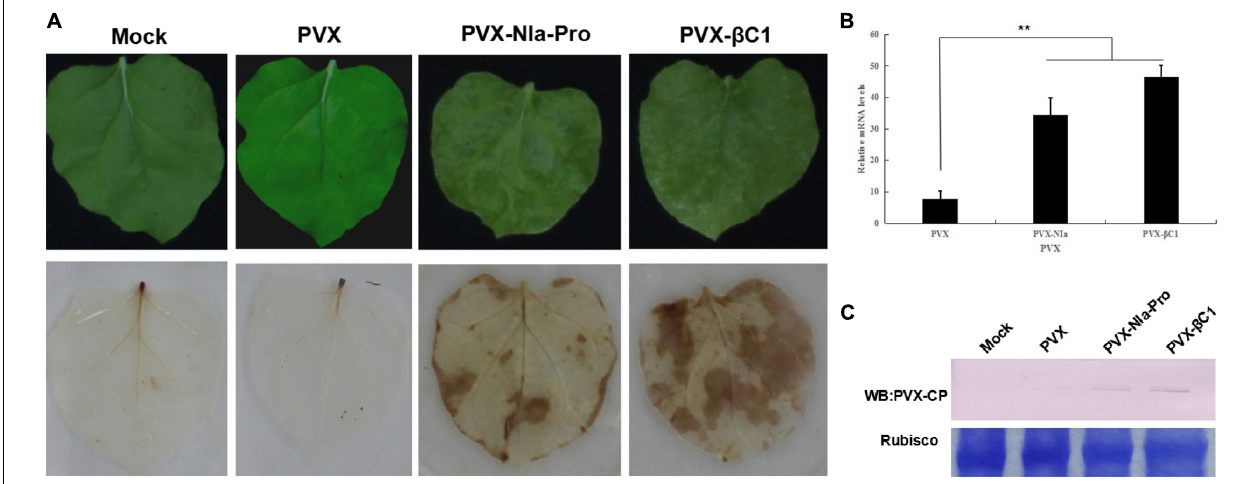
FIGURE 3 | Symptoms exhibited H 2 O 2 accumulation in plants inoculated with potato virus X (PVX) or PVX-NIa-Pro. (A) Severe mosaic symptoms and H 2 O 2 accumulation induced by PVX-NIa-Pro. Nicotiana benthamiana plants were infected with PVX or PVX-NIa-Pro. Upper infected leaves with 3,3’-diaminobenzidine (DAB) staining (lower panel) were photographed directly at 20 dpi. (B) RT-qPCR analysis of PVX genomic RNA in systemic leaves from N. benthamiana plants infected with PVX or PVX-NIa-Pro at 20 dpi. Values are the mean ± SD. Highly significant differences ( ** p < 0.01) between samples in each pair are indicated. (C) Western blotting analysis of PVX CP protein in systemic leaves from N. benthamiana plants infected with PVX or PVX-NIa-Pro at 20 dpi.